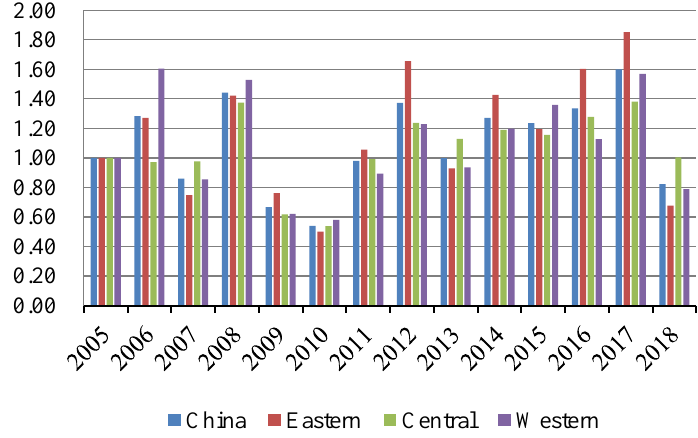
Figure 5. Time trends of technical progress (TC).